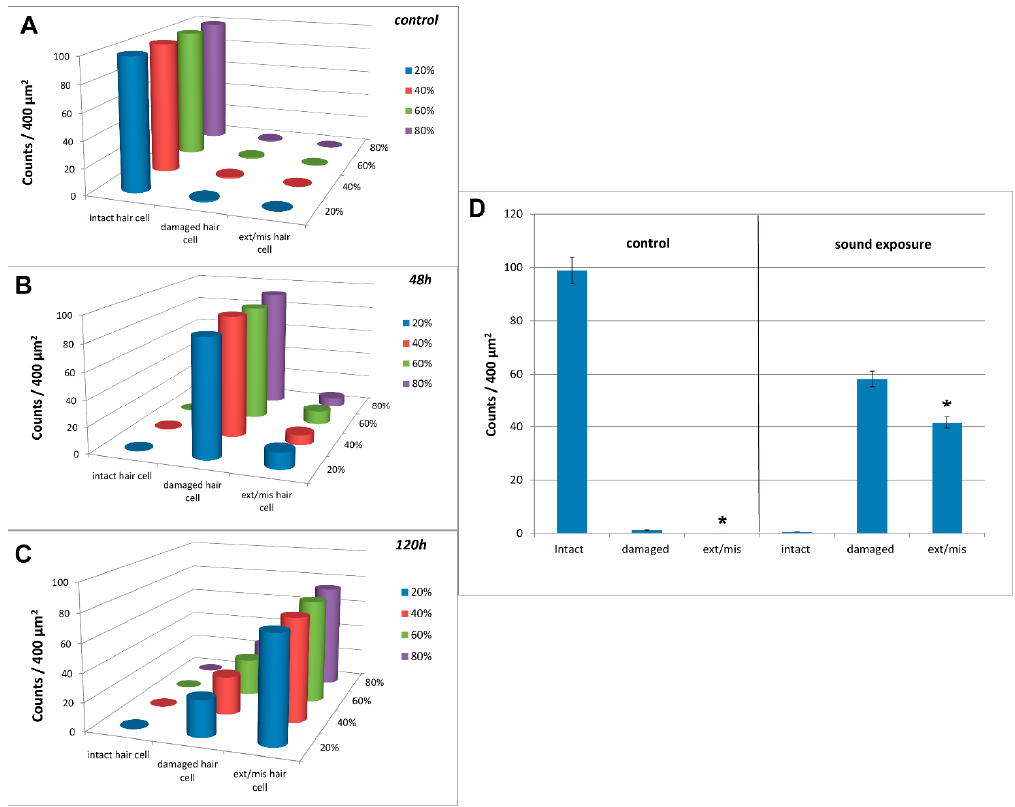
Figure 7. ( A – C ): Mean intact, damaged, and extruded/missing hair cells at 20%, 40%, 60%, and 80% of the total length of sensory epithelium on P. maculata statocyst (48 h and 120 h after sound exposure versus control animals). Note the increase of damaged, extruded, and missing cells versus controls with increase in time. ( D ): Mean (±SE) intact, damaged and ex ‐ truded/missing hair cells after sound exposure (n = 80) versus control (n = 50) on statocyst sensory epithelium of P. macu ‐ lata . Each bar is the average over the 4 regions with the line indicating the standard error. The percentage was computed by dividing by the total count for each individual sample. The lesion severity (see text for definition) of the sound exposure group was found to be significantly higher than that of the control group with p = 9.99 × 10 − 4 (* significant difference).